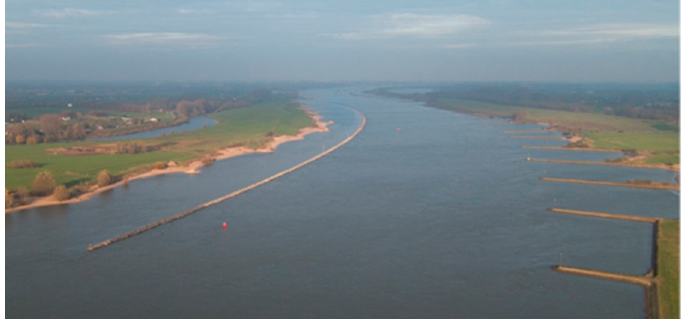
Figure 22. Longitudinal training wall near Ophemert (copyright RWS).